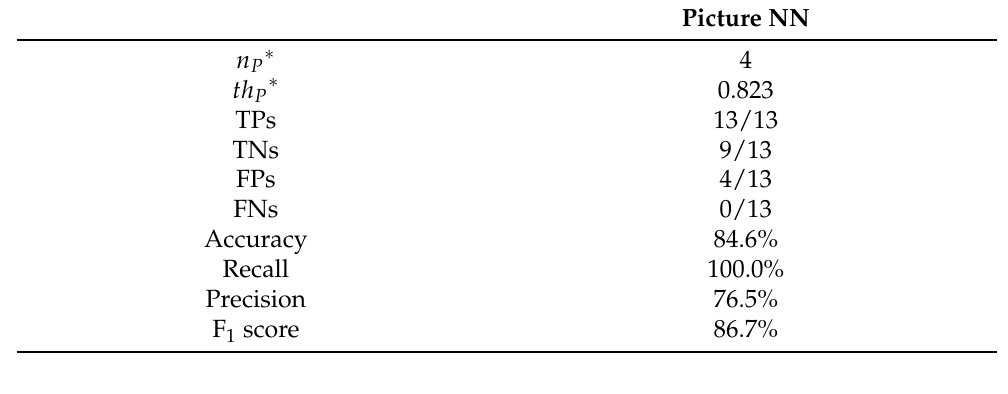
Table 6. Test video results for the picture NN model.